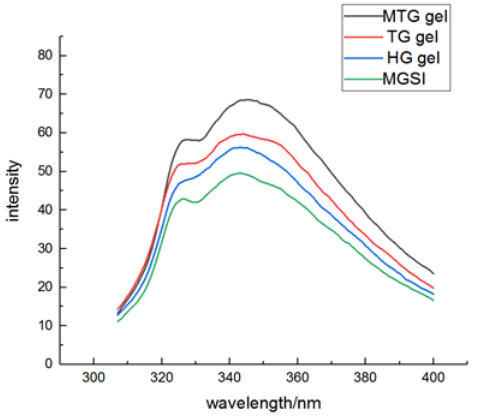
Figure 3. Endogenous fluorescence spectra of different